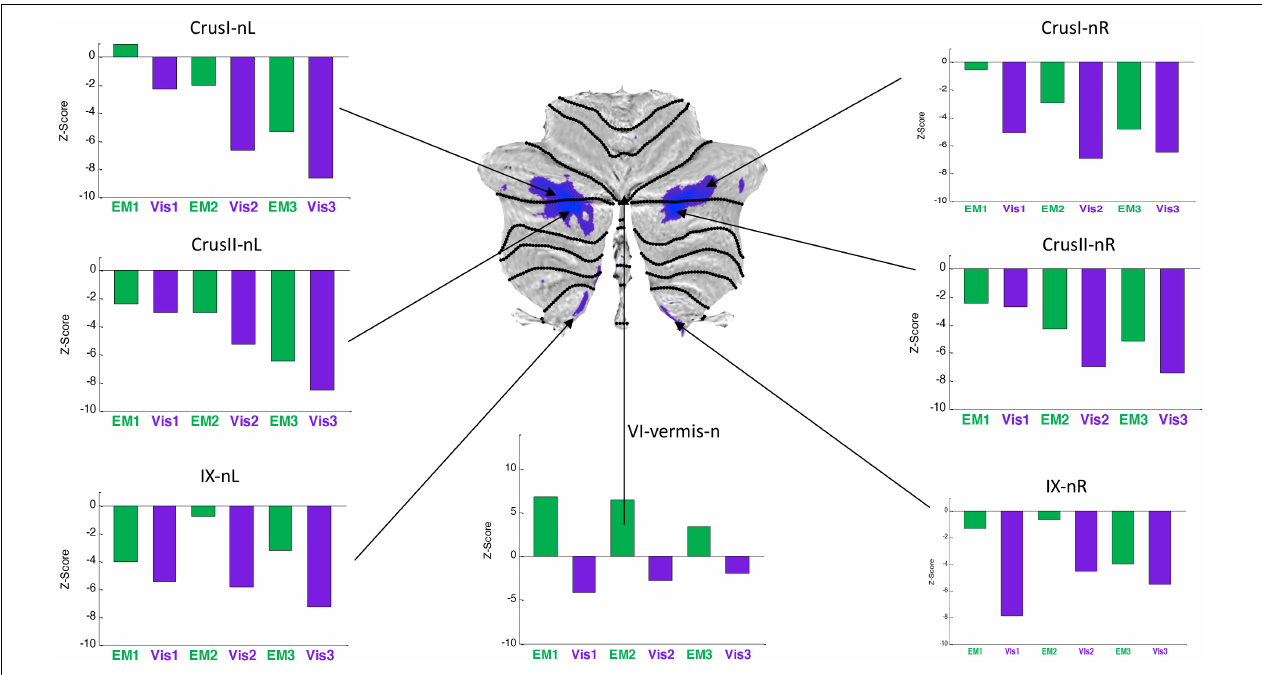
FIGURE 7 | Activation patterns for the task-negative cerebellar lobular ROIs, expressed as z-scores in the same format, and to the same statistical criteria, as for Figure 6 . Note that, the responses were negative for both Visualization ( Vis ) and Explore and Memorize ( EM ) tasks, and tended to become increasingly negative over the three repeats in Crus 1 and Crus II bilaterally. To the significance criteria specified in Figure 6 , responses for Vis in all specified negative ROIs reach the higher criterion for significance in at least one repeat, except for the VI-vermis-n ROI, where EM reached this criterion. Lobule IX showed a hemispherically asymmetric pattern in both tasks, as opposed to the symmetric pattern in Crus I/II, and to the predominant case for the task-positive Vis ROIs of Figure 4 . The VI-vermis-n ROI produced weak negative Vis responses, but in contrast the rest of these ROIs, its EM responses inverted to positive activation; in general, both Vis and EM responses became significantly more negative over the